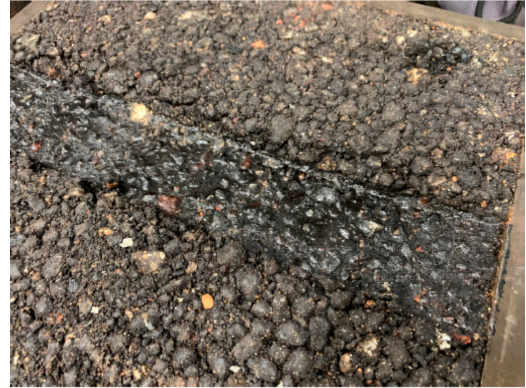
Figure 11. Wheel track testing sample.